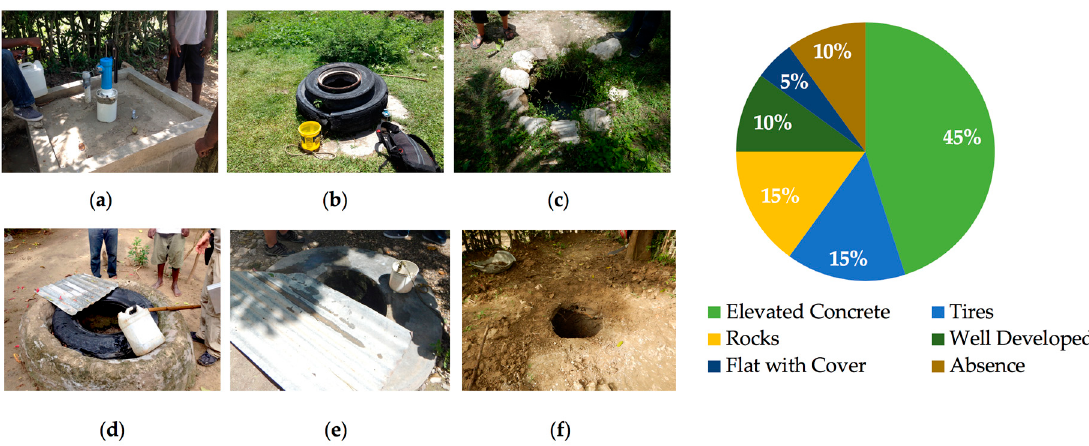
Figure 6. Hand–dug well collar variations: ( a ) elevated concrete; ( b ) tires; ( c ) rocks; ( d ) well developed; ( e ) flat with cover; ( f ) no collar/absence.